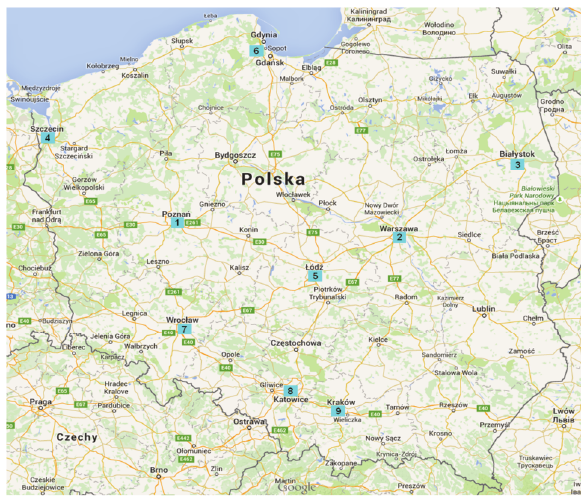
Fig. 4. Map of Poland with marked sites of the proposed public hydrogen refuelling station locations [17]